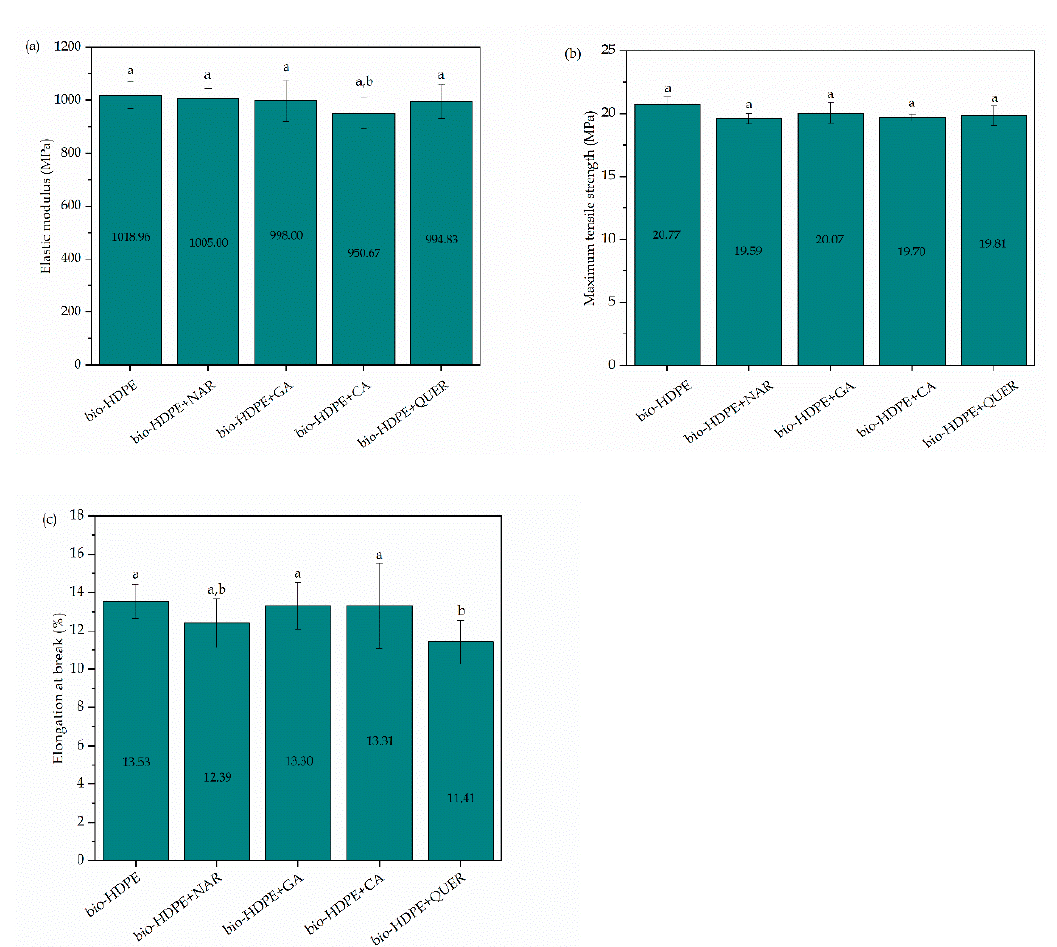
Figure 6. Mechanical properties of the thermo-compressed bio-based high-density polyethylene (bio-HDPE) films containing naringin (NAR), gallic acid (GA), caffeic acid (CA), and quercetin (QUER) in terms of: ( a ) elastic modulus; ( b ) maximum tensile strength; ( c ) elongation at break. a,b Different letters in the same property indicate a significant difference among the samples ( p < 0.05).